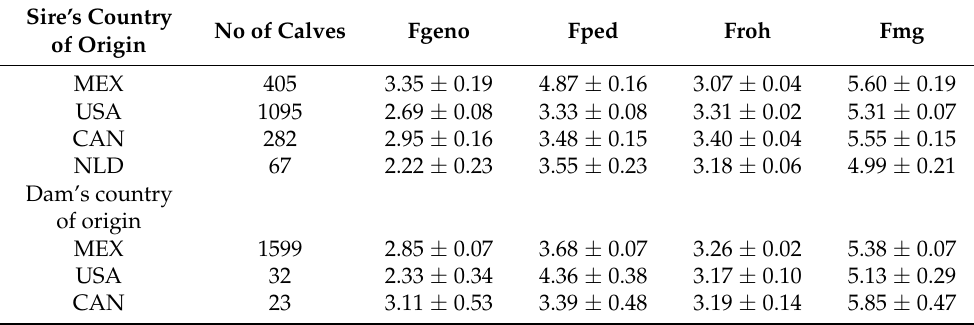
Table 4. Inbreeding coefficients in % ( ± SE) for animals with positive Fgeno, grouped by sire and dam’s country of origin.